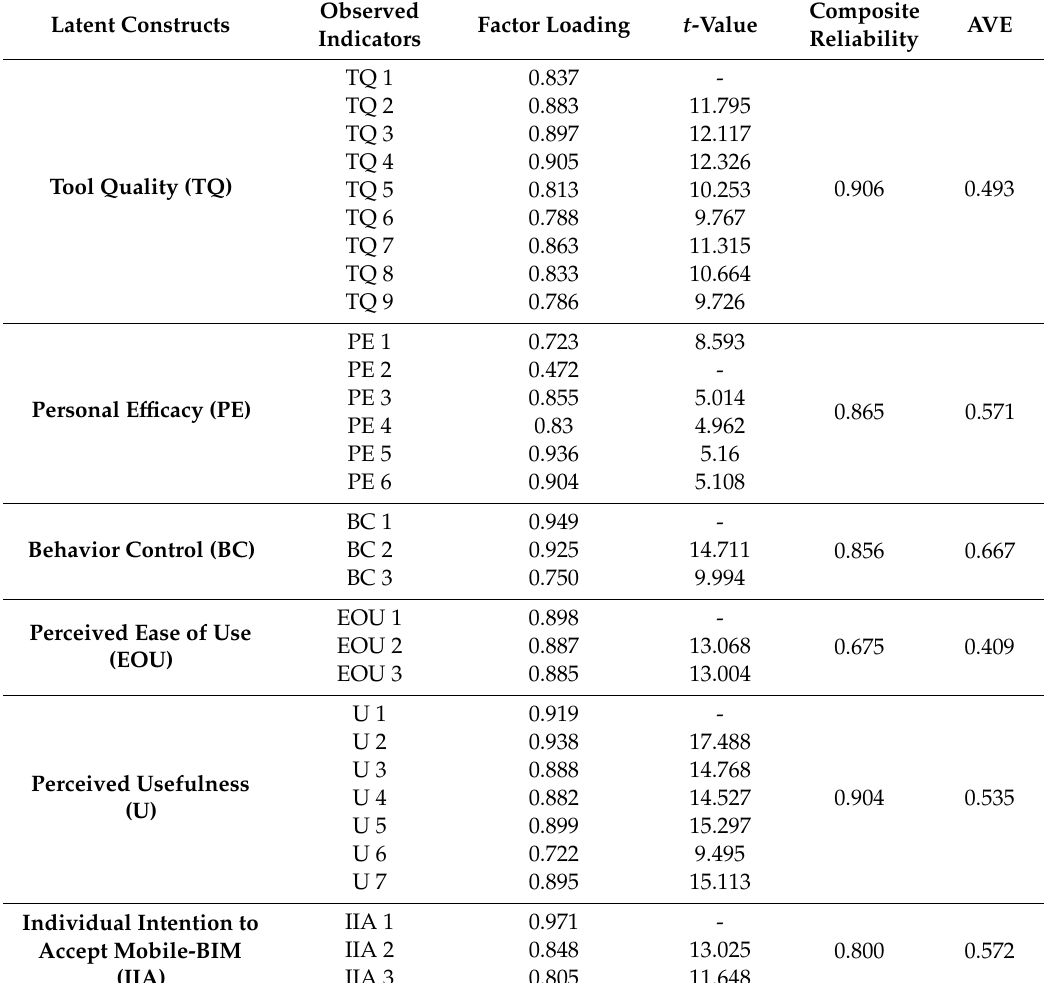
Table 9. Results of CFA.